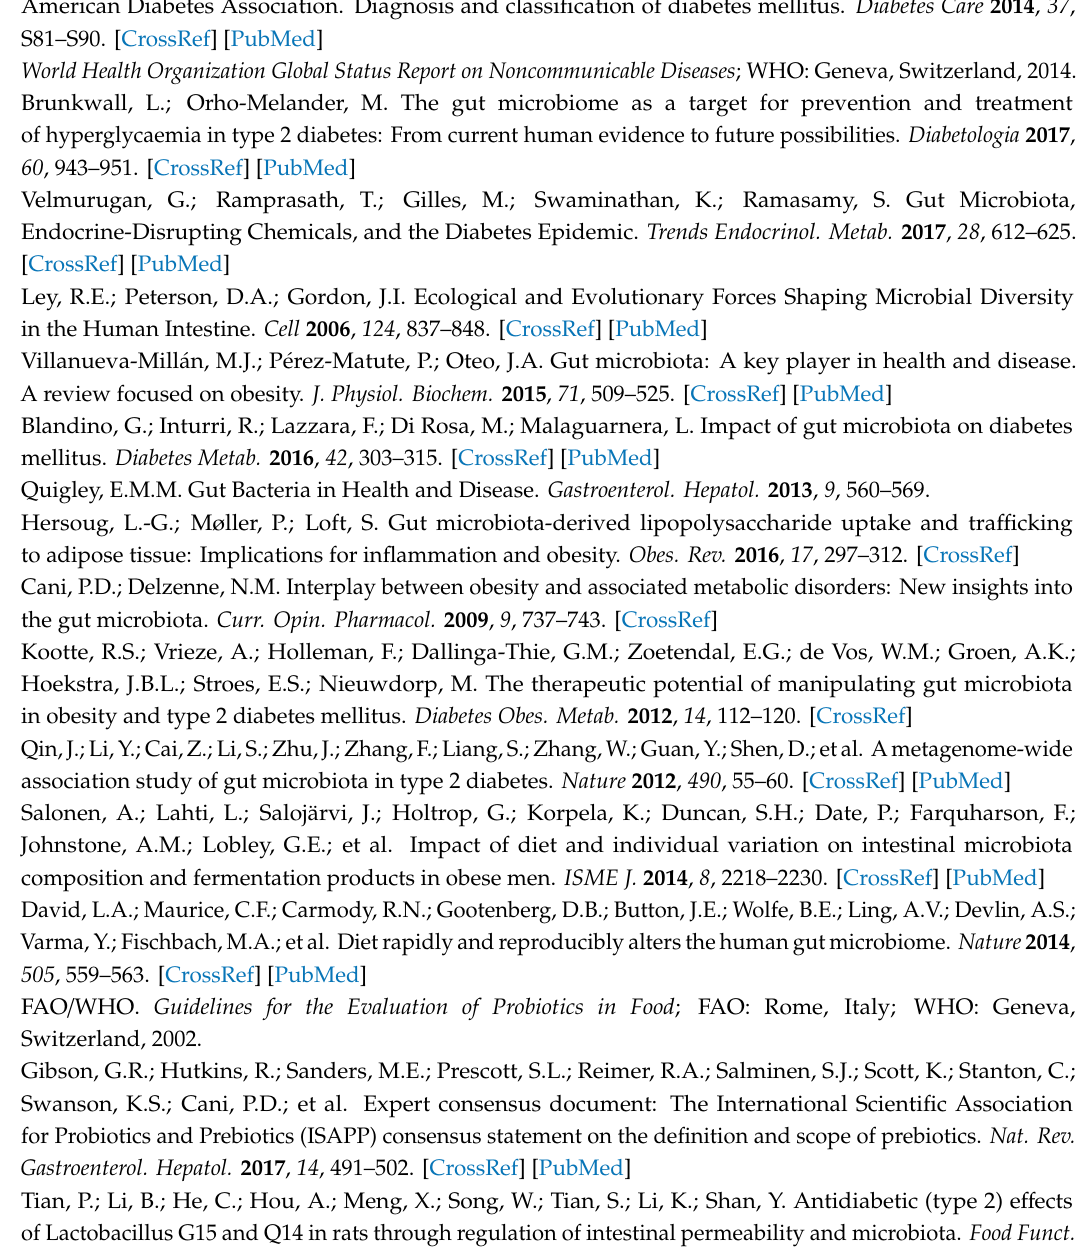
Table S6: List of bacteria species and OTUs which were identified exclusively in the T